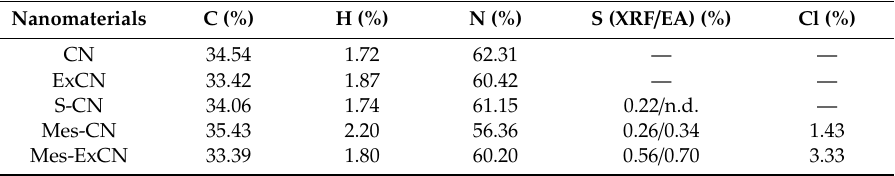
Table 1. Elemental composition of carbon nitride (CN)-based nanomaterials. XRF, X-ray fluorescence spectroscopy; EA, elemental analysis; CI, confidence